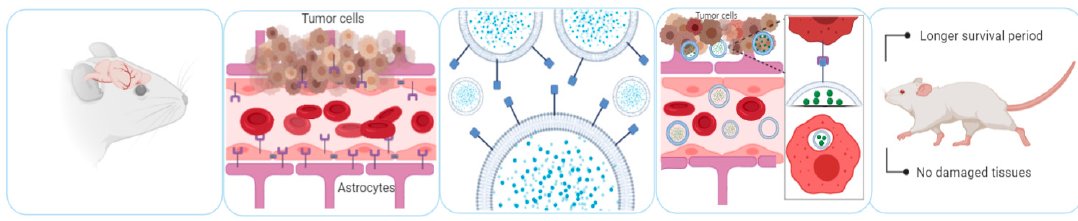
Figure 3. Engineering of the EVs to increase target specificity. Blood-brain-barrier, glia and tumor cells expressed the low-density lipoprotein (LDL) receptor. EVs loaded with methotrexate were conjugated with a surface peptide targeting the LDL receptor. In a mice model, administration of these modified EVs resulted in longer survival period and no damage of other tissues, as frequently observed with conventional chemotherapy strategies [178].